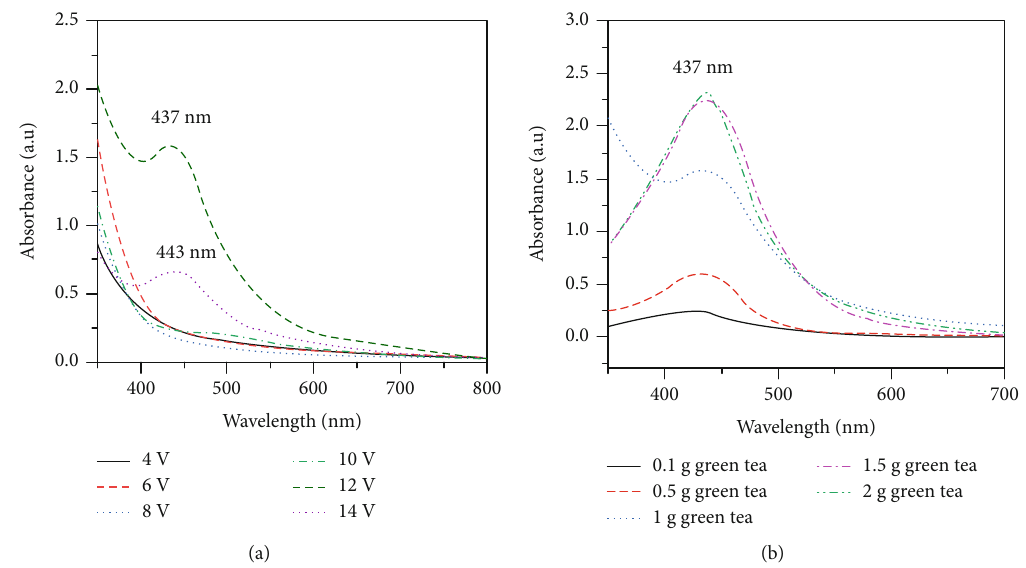
Figure 1: UV-vis spectra of the synthesized biogenic AgNPs corresponding to the di ff erent supplied voltages from (a) 4V to 14 V and di ff erent amounts of green tea from (b) 0.1g to 2 g.